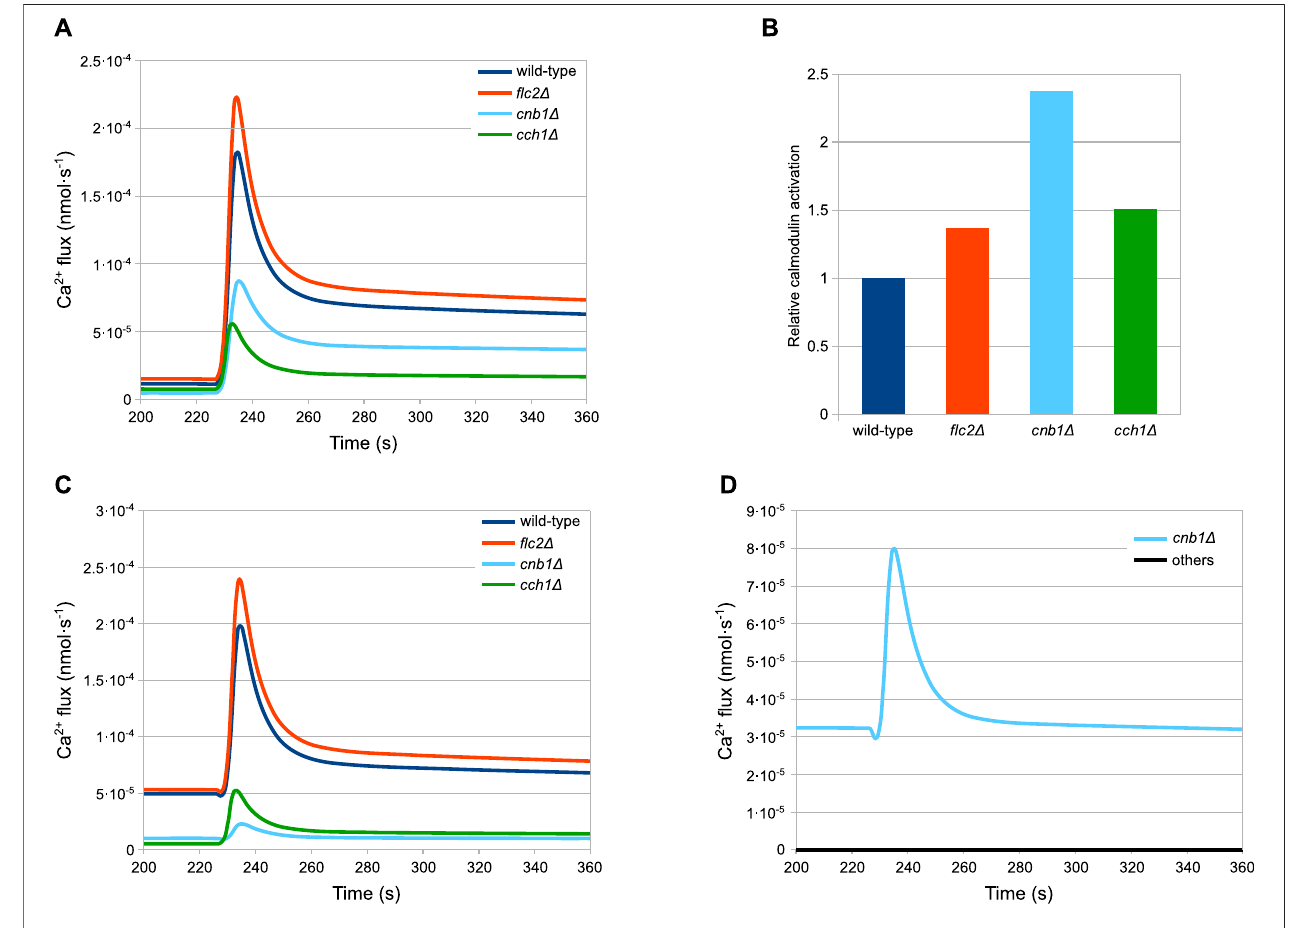
FIGURE 5| Simulationsshowing the main differencesamong the considered strains. (A) MS in fl ux. (B) Calmodulin activation. (C) Pmc1 fl ux. (D) Vcx1 fl ux (A,C,D) Fluxes through the most relevant channels. (B) Calmodulin activation, shown relative to the wild-type level, before HTS is applied. Time traces of calcineurin are similar and are not shown for the sake of fi gure readability. (D) Vcx1 fl uxes of all mutants but cnb1 Δ are overlapping and therefore are coloured